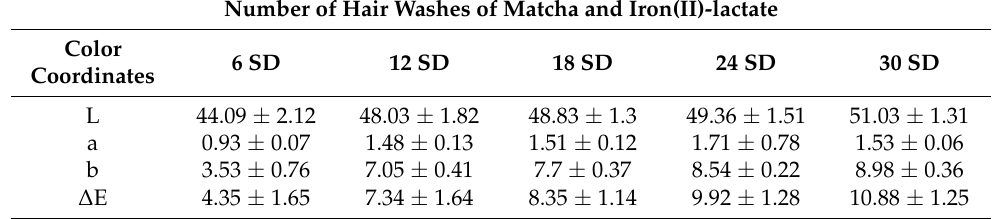
Table 4. Color coordinates, L, a, b, and ∆ E of hair tresses dyed with iron(II)-lactate in combination with 10 wt% matcha (n = 5). SD: standard